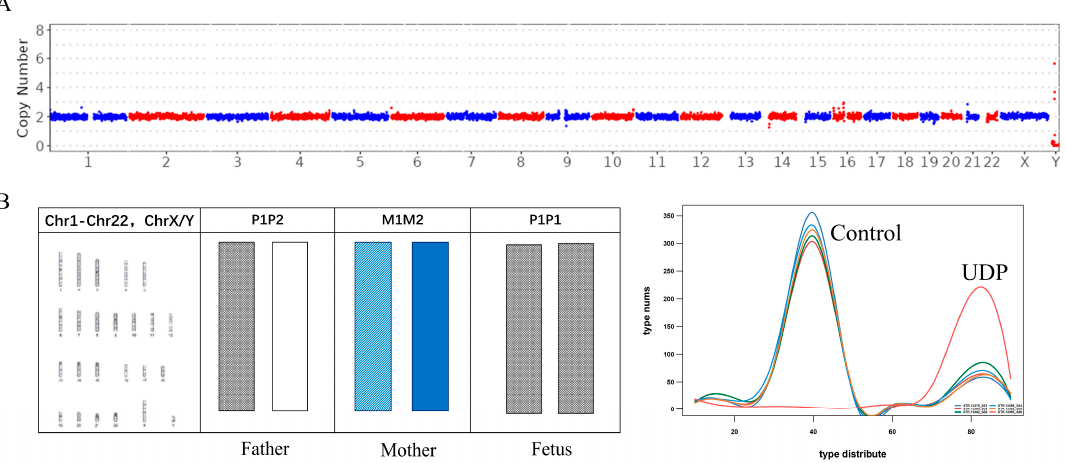
Figure 3. Results of CNV-seq and STR panel detection of UDP miscarriage samples. ( A ) Plot of CNV- seq detection results of UDP. ( B ) Chromosomal G-banding and STR detection results of miscarriage sample UDP. The control curve represents the proportion of chromosomal STR loci tested that are identical to the constructed chromosomal haplotype STR loci of approximately 50%. The UDP curve represents approximately 100% of the detected chromosomal STR loci identical to the constructed chromosomal haplotype STR loci.